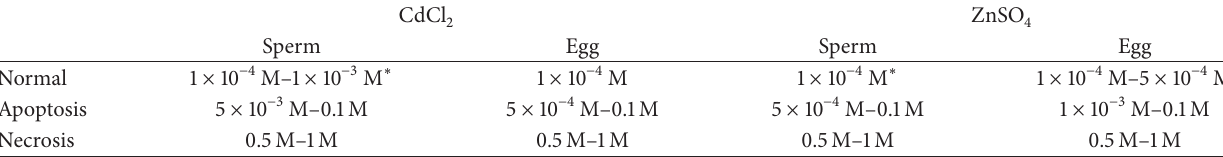
Table 1: Summary of viability assay on T. gratilla gametes treated with CdCl 2 and ZnSO 4 .